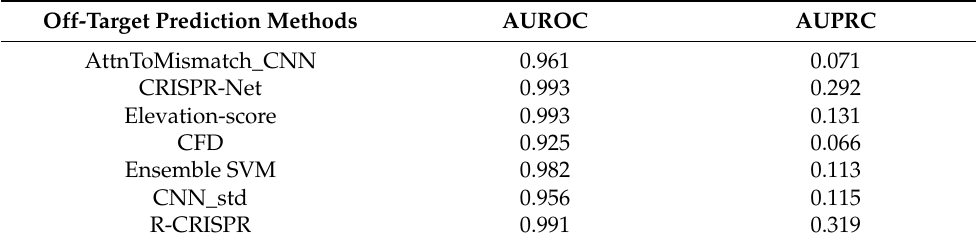
Table 3. Performance of seven off-target prediction methods on Dataset GUIDE_II.